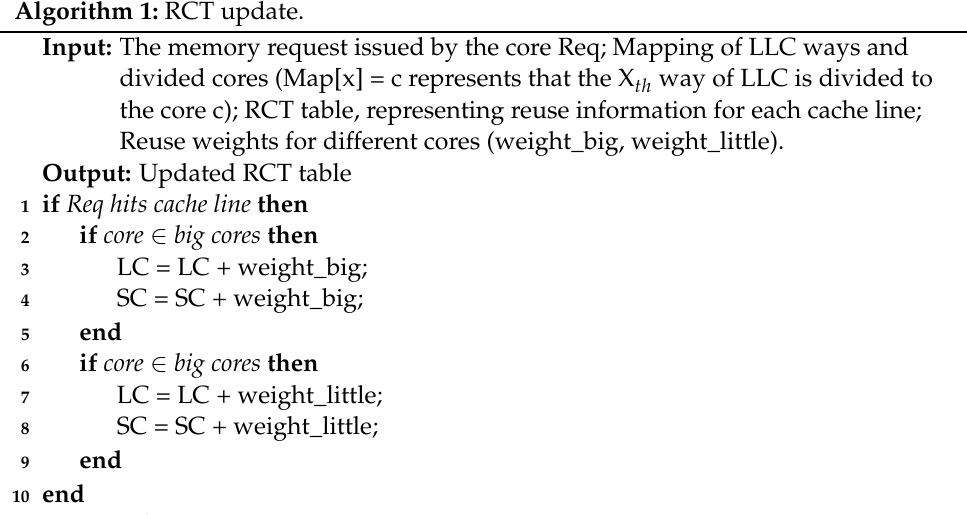
Figure 2. Overview of the HAPC. Algorithm 1: RCT